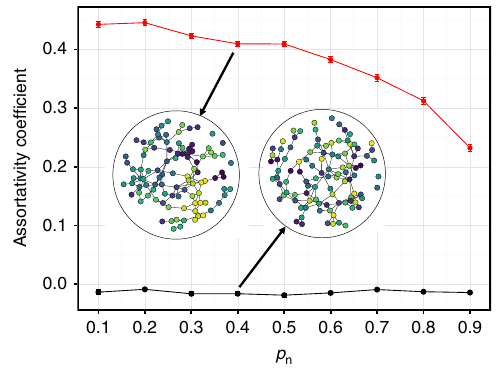
Figure 5 | Assortativity as a consequence of social inheritance. Illustration of assortativity without explicit assortative preference. Dots and notches note assortativity coefficients and standard errors, respectively, for model networks (red) and shuffled networks, where trait values were re-assigned randomly (black). Inset networks illustrate examples from the two groups. Circle colours represent arbitrary continuous trait values. Lines represent social bonds between individuals. Parameter values are the same as in Fig. 4, with mutation probability m ¼ 0.05.